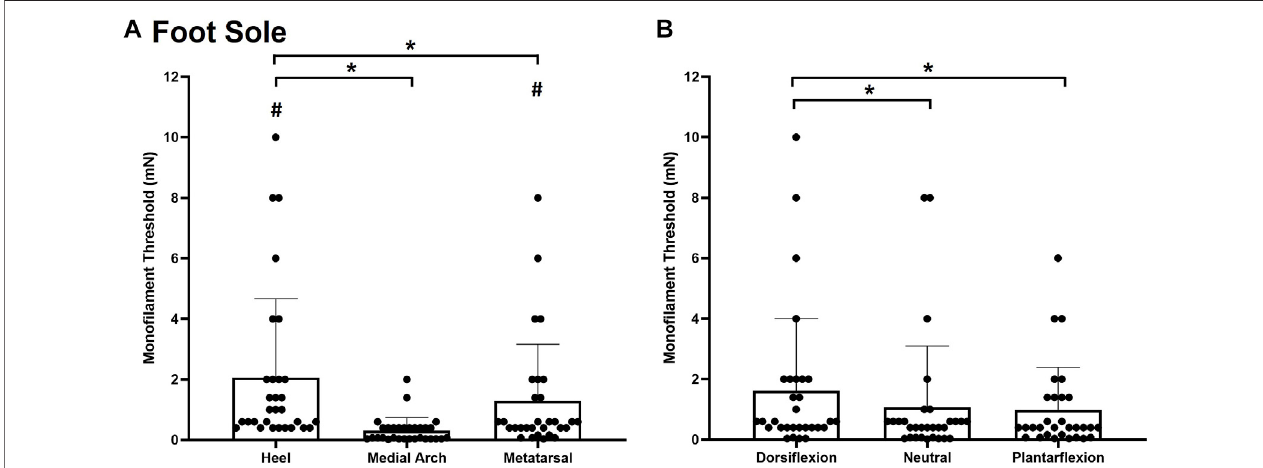
FIGURE 3 | Mean (+SD) touch mono fi lament threshold at the test sites on the foot sole (A) and the three ankle postures (B) . Asterisks indicate a signi fi cant difference ( p < 0.05). Pound symbols indicate a signi fi cant difference from the medial arch site (A) ( p < 0.05). Dots represent threshold values for each participant.